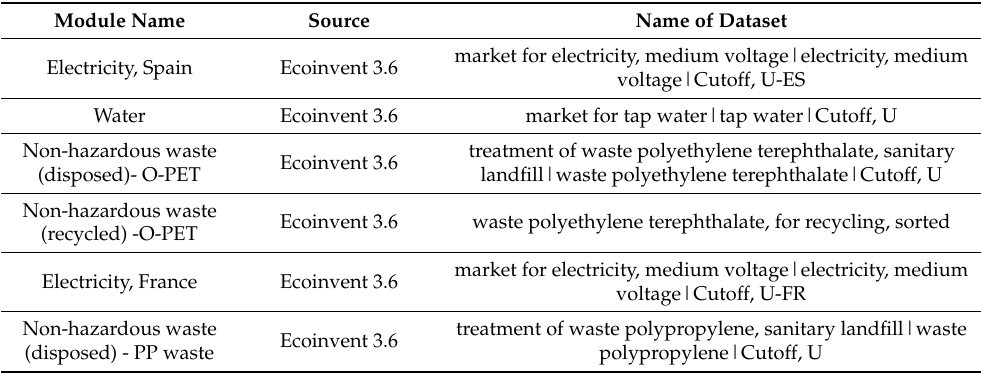
Table 3. Database data used in the LCIA